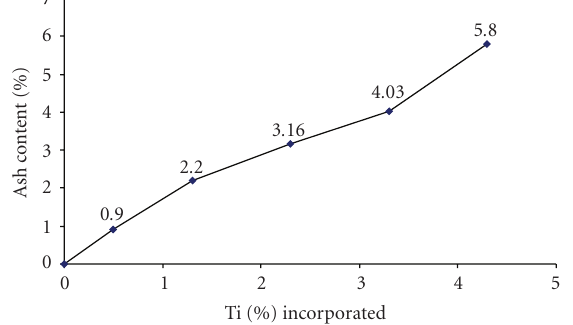
Figure 7: Ash content increases with increase in titanium content confirming the dispersion of titanium in the acrylate